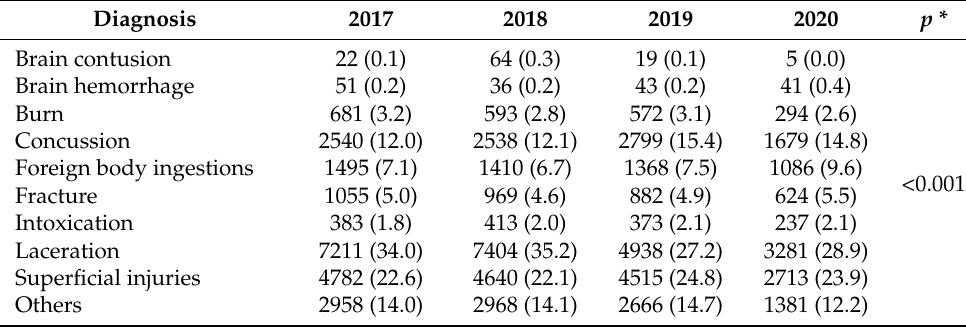
Table 3. Changes in the detailed distribution of injury-related disease, N (%).